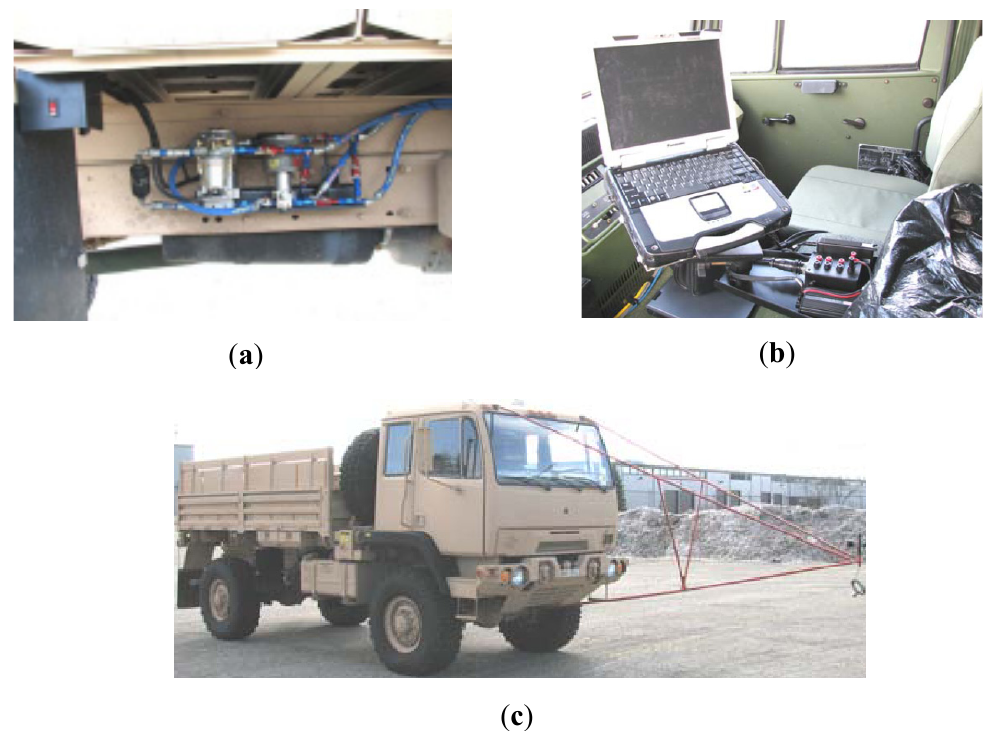
Figure 4. Vehicle instrumentation. ( a ) Fuel flow meter installation; ( b ) Data acquisition instrumentation; ( c ) Wind sensor